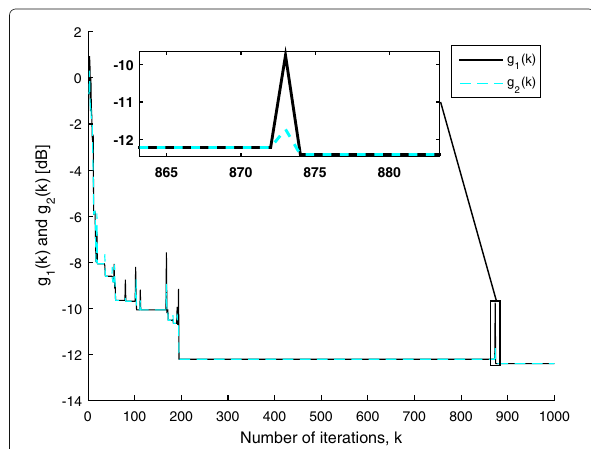
Fig. 6 Values of g 1 ( k ) and g 2 ( k ) over the iterations for the SM-AP algorithm with γ ( k ) as the SC-CV when the noise bound is known, where g 1 ( k ) and g 2 ( k ) are the numerator and denominator of (26) in Theorem 3, when an update occurs; otherwise, g 1 ( k ) = (cid:3) ˜ w ( k + 1 ) (cid:3) 2 and g 2 ( k ) = (cid:3) ˜ w ( k ) (cid:3) 2